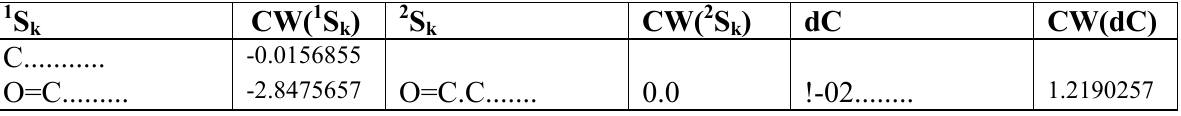
Table 2. Example of definition of SMILES attributes (unused positions are indicated by dots). 1 S